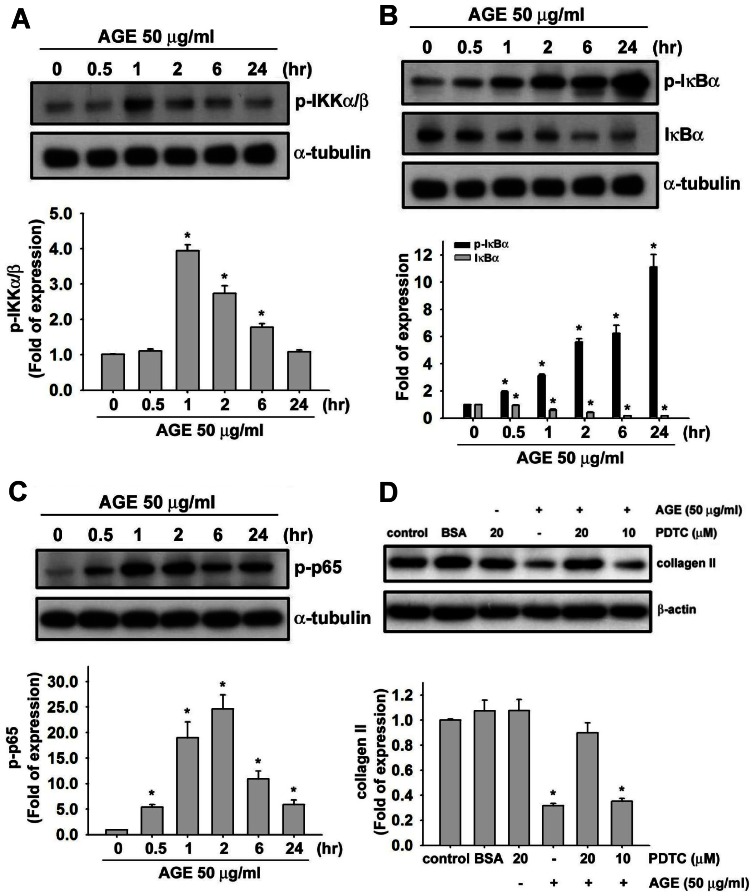
AGEs activate NF-κB signaling in human OA chondrocytes.Human OA chondrocytes (1×106/ml) were incubated with AGEs (50 µg/ml) for indicated time intervals. The phosphorylations of IKKα/β (A), IκBα (B) and p65 (C) and the degradation of IκBα (B) were determined by Western blotting. In D, Chondrocytes were pretreated with PDTC (20 µM) for 1 hour followed by treatment with AGEs for 2 hours. Protein expression of collagen II was determined by Western blotting. Densitometric analysis for p-IKKα/β, p-IκBα, IκBα, p-p65, and collagen II levels corrected to α-tubulin is shown. All data are presented as mean ± SEM for three independent experiments. *: P<0.05 versus control. #: P<0.05 versus AGEs alone.